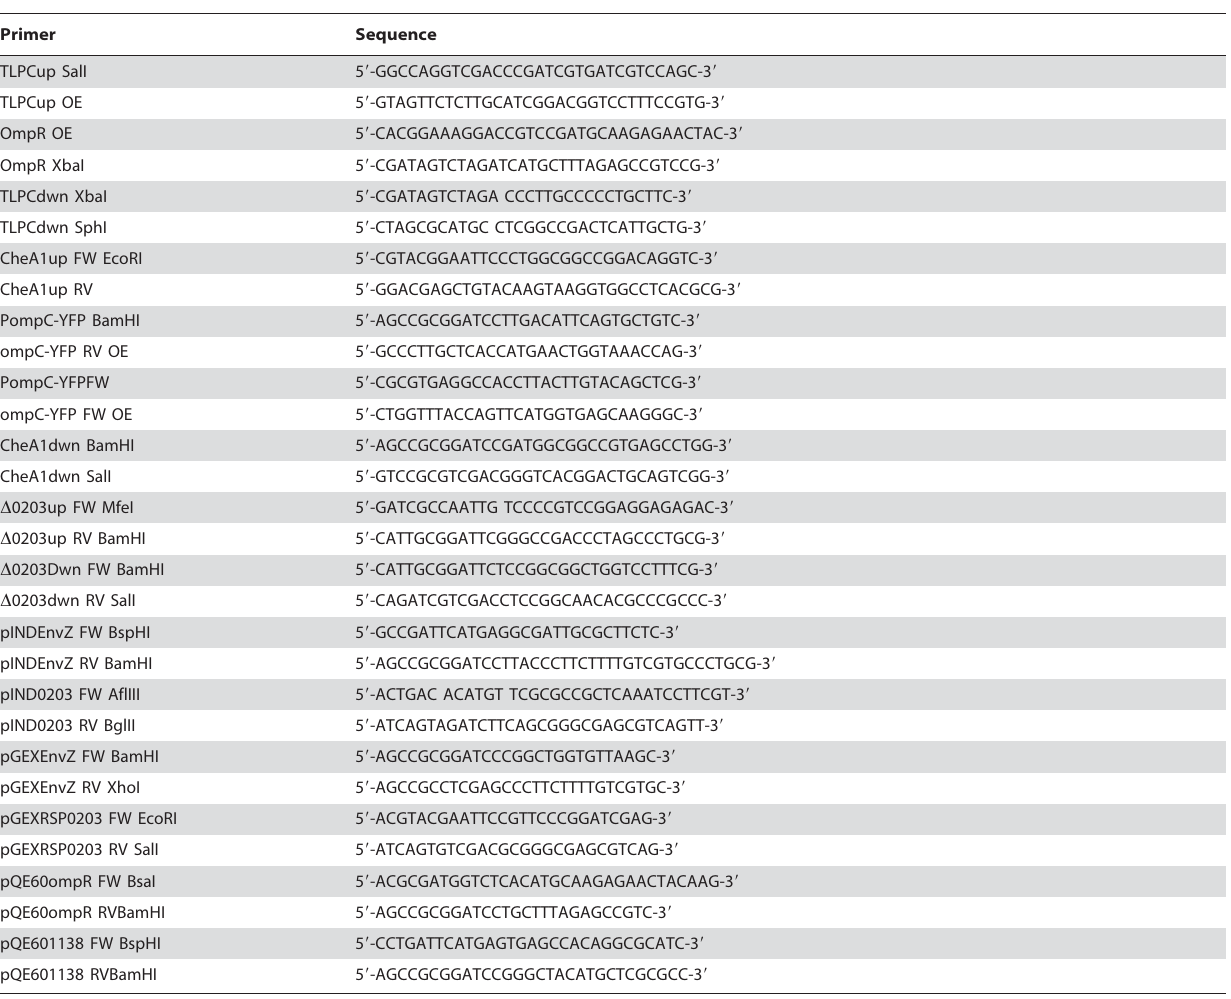
Table 4. Table of primers used in this study.